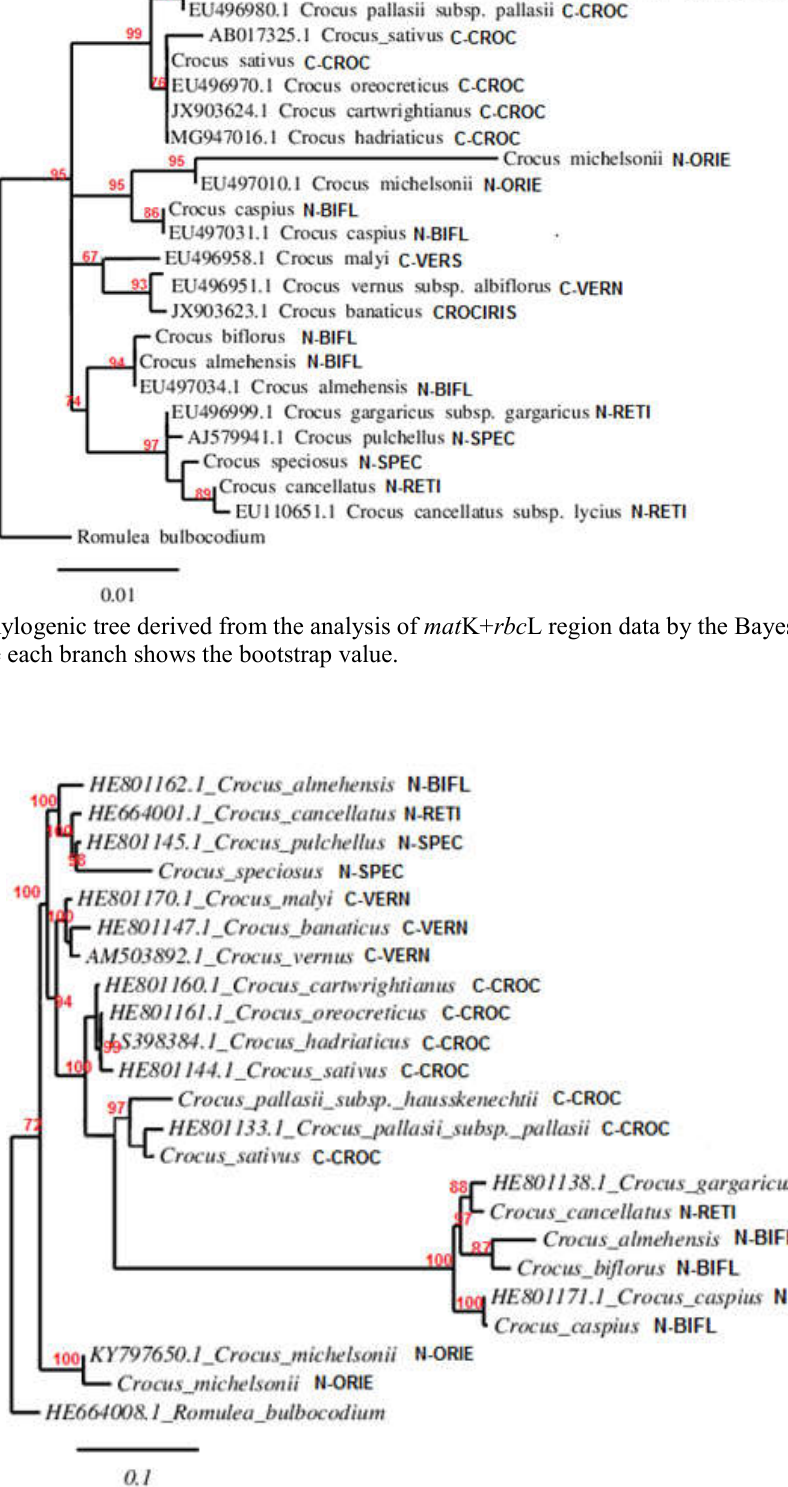
Fig. 6. The phylogenic tree derived from the analysis of ITS+ mat K+ trn L region data by the Bayesian method, the number above each branch shows the bootstrap